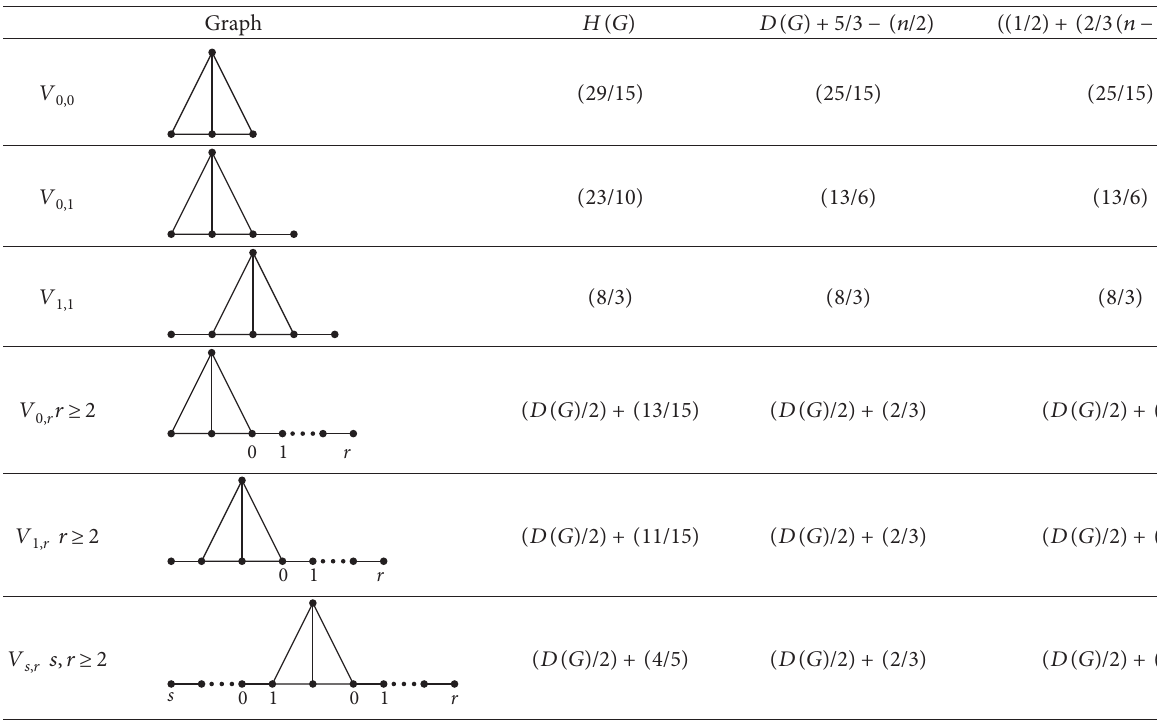
Table 1: All possibilities for Case 3 of Theorems 3 and